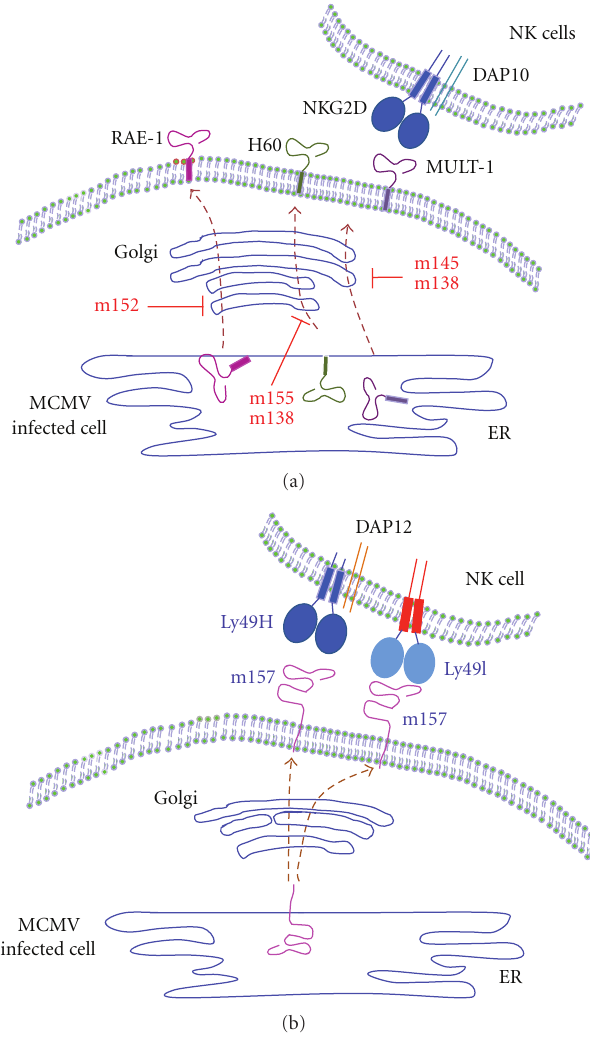
Figure 1: MCMV-encoded proteins disrupt NK-cell recognition of infected cells. During MCMV infection, the surface expression of the stress-induced molecules, ligands for NKG2D, is downregulated: m152 downregulates all isoforms of RAE-1, m145 and m155 inter- fere with H60 and MULT-1, respectively, and m138 downregulates H60, MULT-1, and RAE-1 ε (a). m157 binds both inhibitory NK receptor, Ly49I, and activating NK receptor, Ly49H